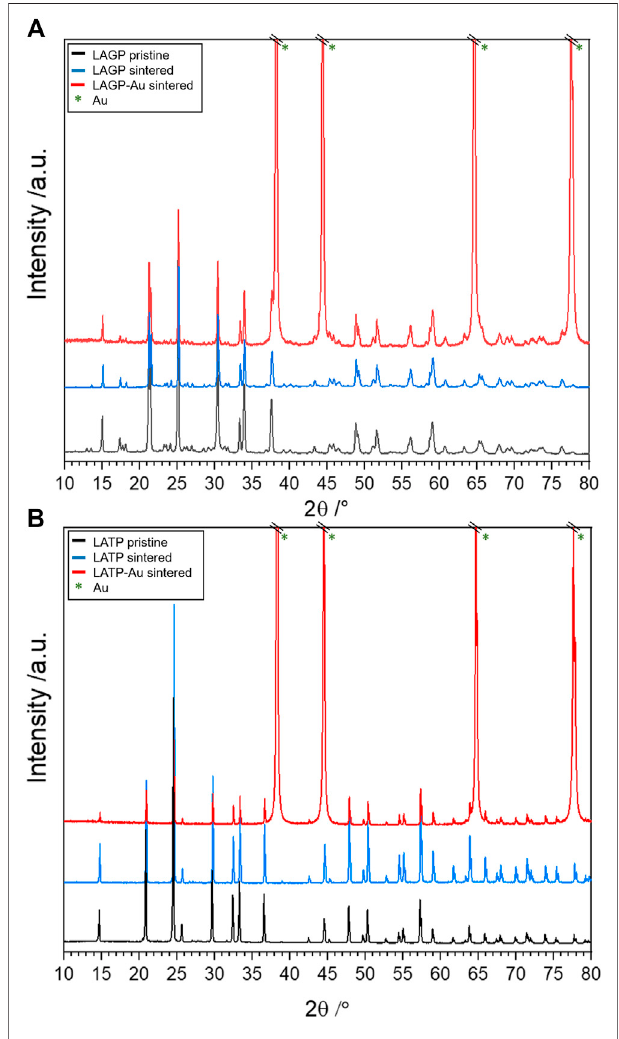
FIGURE 1 | PXRD pattern of (A) LAGP and (B) LATP pristine powders compared to the sintered pellets, with and without gold particles, using SPS.